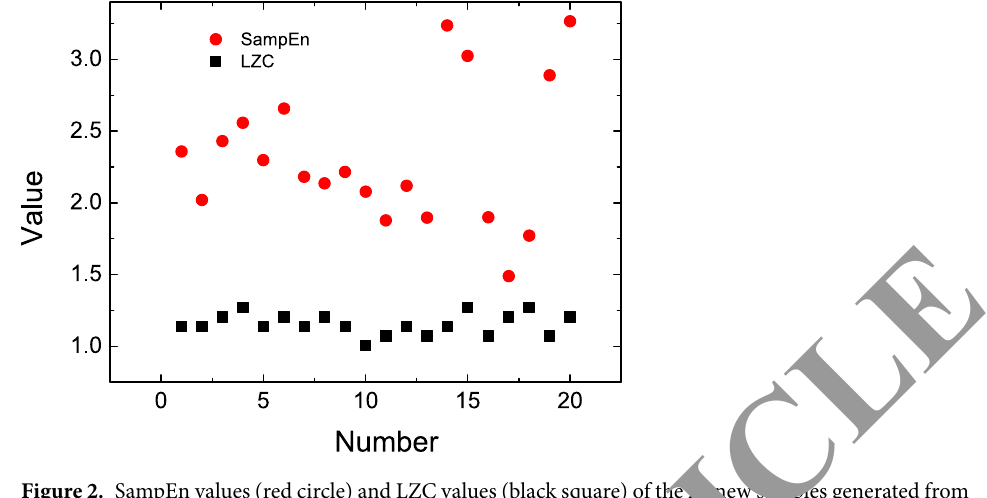
Figure 2. SampEn values (red circle) and LZC values (black square) of the 20 new samples generated from the 2000-year record with annual resolution, each resolved on a 20-year time scale (see main text). The mean SampEn value of these 20 records is 2.3 and the deviation is 0.5. The mean LZC value of these 20 records is 1.16 and the deviation is